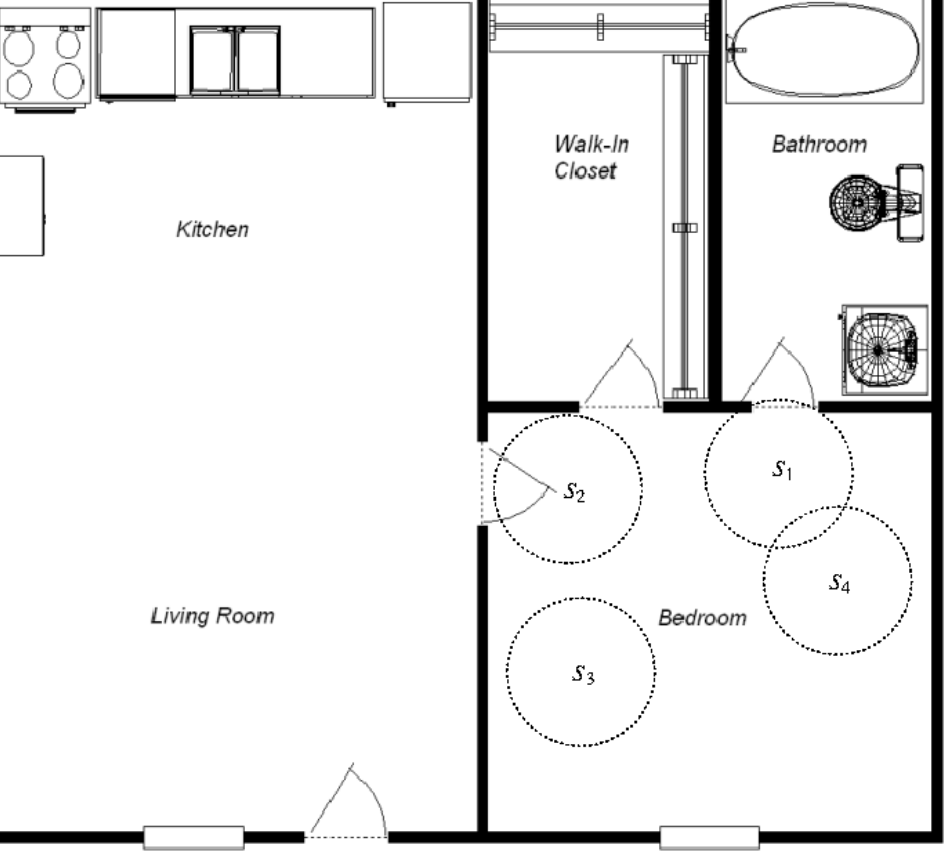
Figure 1. Floor plan of an apartment equipped with motion